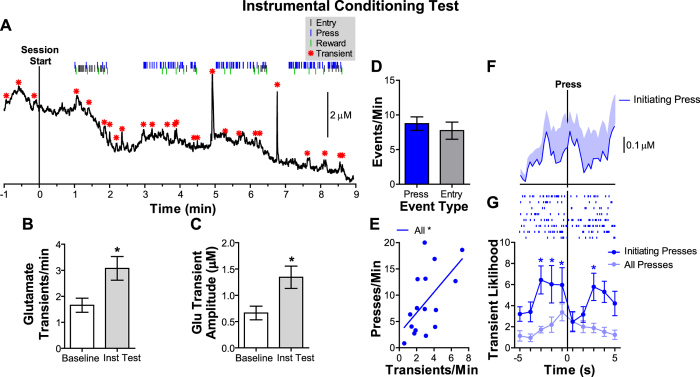
Basolateral amygdala glutamate release during instrumental conditioning.(A) Representative glutamate concentration v. time trace during instrumental conditioning. Instrumental session started with lever insertion at time 0 s. Red asterisks represent significant transient glutamate concentration fluctuations above baseline (transients). Behavioral events are marked above the trace. (B) BLA glutamate transients that reached threshold were counted and averaged for each rat across the 2-min pre-test baseline period and the instrumental (inst) test sessions. (C) Glutamate transient amplitude (μM) was calculated as the peak amplitude of the transient minus the baseline concentration (first minima 0.5–5 s before the peak). (D) Lever press and food-port entry rate collapsed across the instrumental conditioning tests. (E) Between-subject correlation between glutamate transient frequency (Transients/min) and lever-press rate (Presses/min). Each rat is represented twice, once for each instrumental test. (F) Glutamate concentration v. time trace around initiating lever presses (occurring at time 0 s) averaged across all initiating presses in the session for a representative subject. Shading reflects +1 SEM across trials. (G) The likelihood of a glutamate transient in 10, 1-s bins, evenly distributed around presses divided by initiating presses (first press after the collection of an earned reward or after a >6 s pause in pressing, excluding presses that occurred within a pressing bout) or all lever presses combined (including both initiating and intra-bout presses), averaged across the two instrumental tests. The press occurs at time 0 s. Likelihood of a glutamate transient is defined as the percentage of presses (or initiating presses) that had a glutamate transient in the represented 1-s time bin. Asterisks represent significance relative to the control 1-s time bin, 5 s prior to the press. The raster plot shows the corresponding raw data with each subject represented on an individual line on the y-axis, tick marks represent the peak time of each significant glutamate transient surrounding initiating presses. Error bars +1 SEM. *p < 0.05, ***p < 0.001.